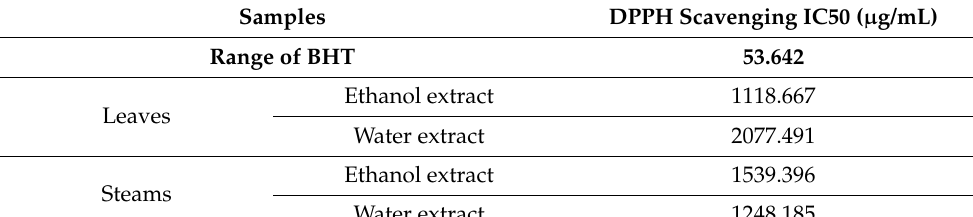
Figure 2. DPPH free radical scavenging activity curves of water and ethanol extracts of leaves and stems.